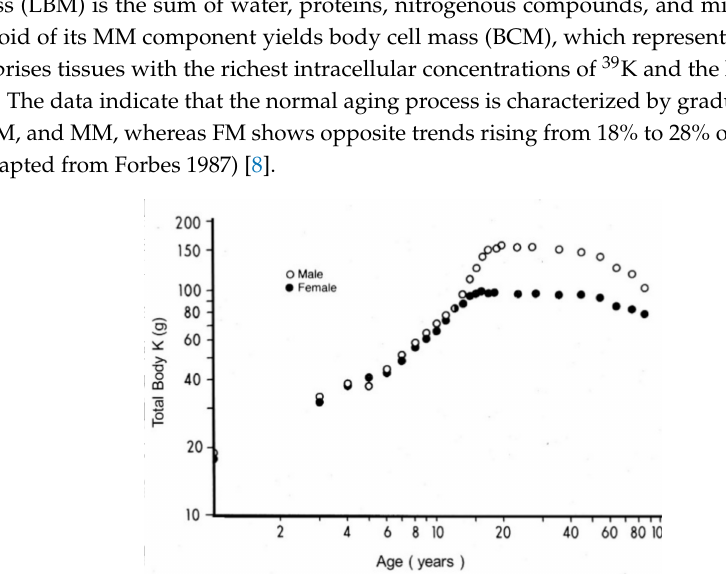
Figure 2. Evolutionary patterns of LBM values throughout the human lifespan. Compilation of seven di ff erent clinical investigations performed in healthy subjects from birth to very old age and showing body accretion of TBK levels determined by the measurement of the naturally occurring 40 K radioisotope using dual-energy X-ray absorptiometry (DXA). The pioneer devices designed to appraise whole body counting and 40 K in biological tissues were built up at the University of Rochester, Rochester, NY 14642, USA, under the guidance of Gilbert B. Forbes, in close collaboration with the International Atomic Energy Agency, Vienna, Austria. The results are plotted against age on double-logarithmic coordinates. Here, 95% of TBK is sequestered within metabolically active tissues and is narrowly correlated with total body N (TBN), making this last parameter a reliable tool to assess LBM values in health and disease [8]. Starting from the sixties, transthyretin (TTR) reveals a stepwise drop in the process of time with a steeper slope in elderly men that reflects a relatively more rapid decrease in their muscle